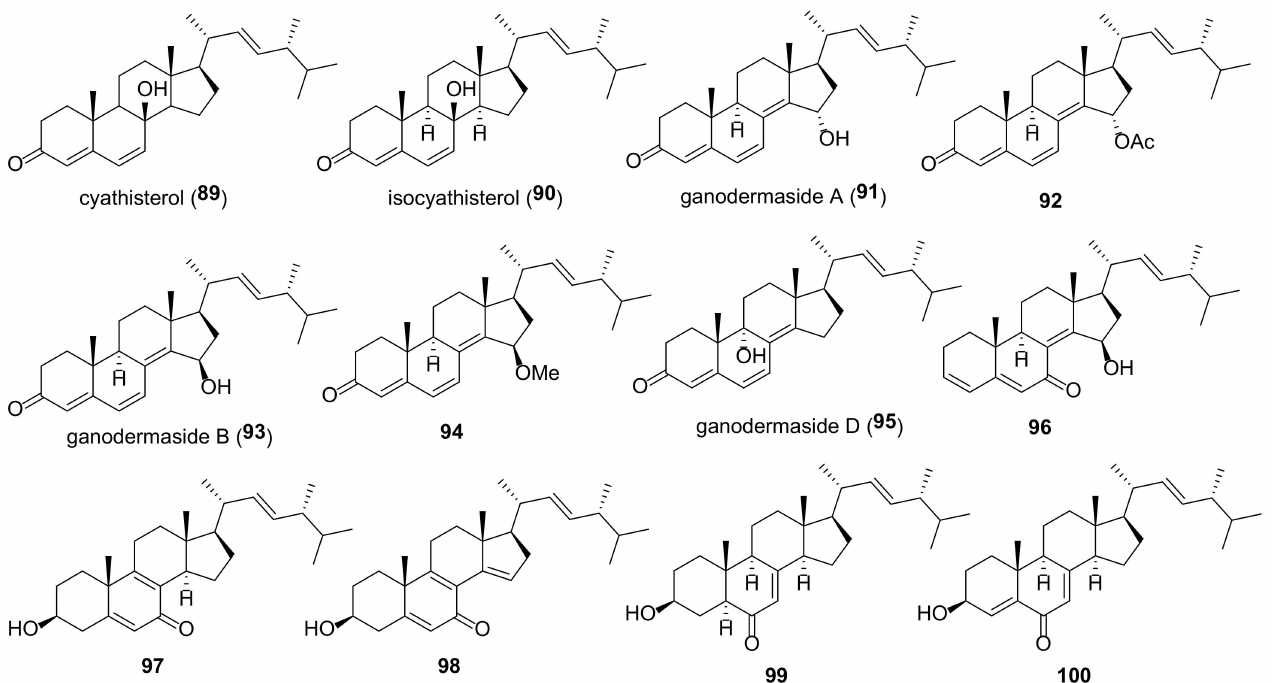
Figure 11. Structures of fungal hydroxyketones with two functional groups.